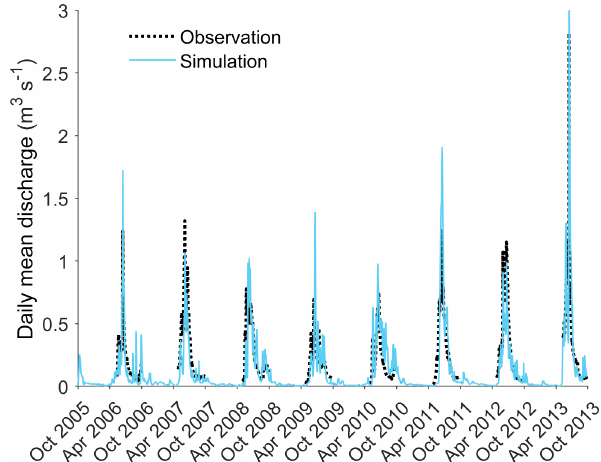
Figure 5. Comparison of the observed and simulated daily stream- flow at the basin outlet over 2005–2013 for Marmot